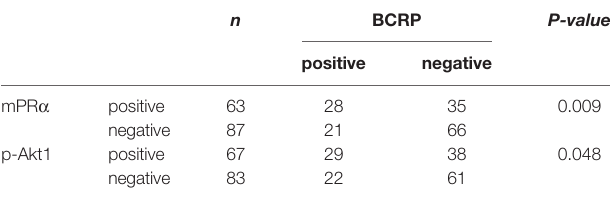
TABLE 3 | Expression of mPR a , p-Akt1, and BCRP in invasive breast cancer.